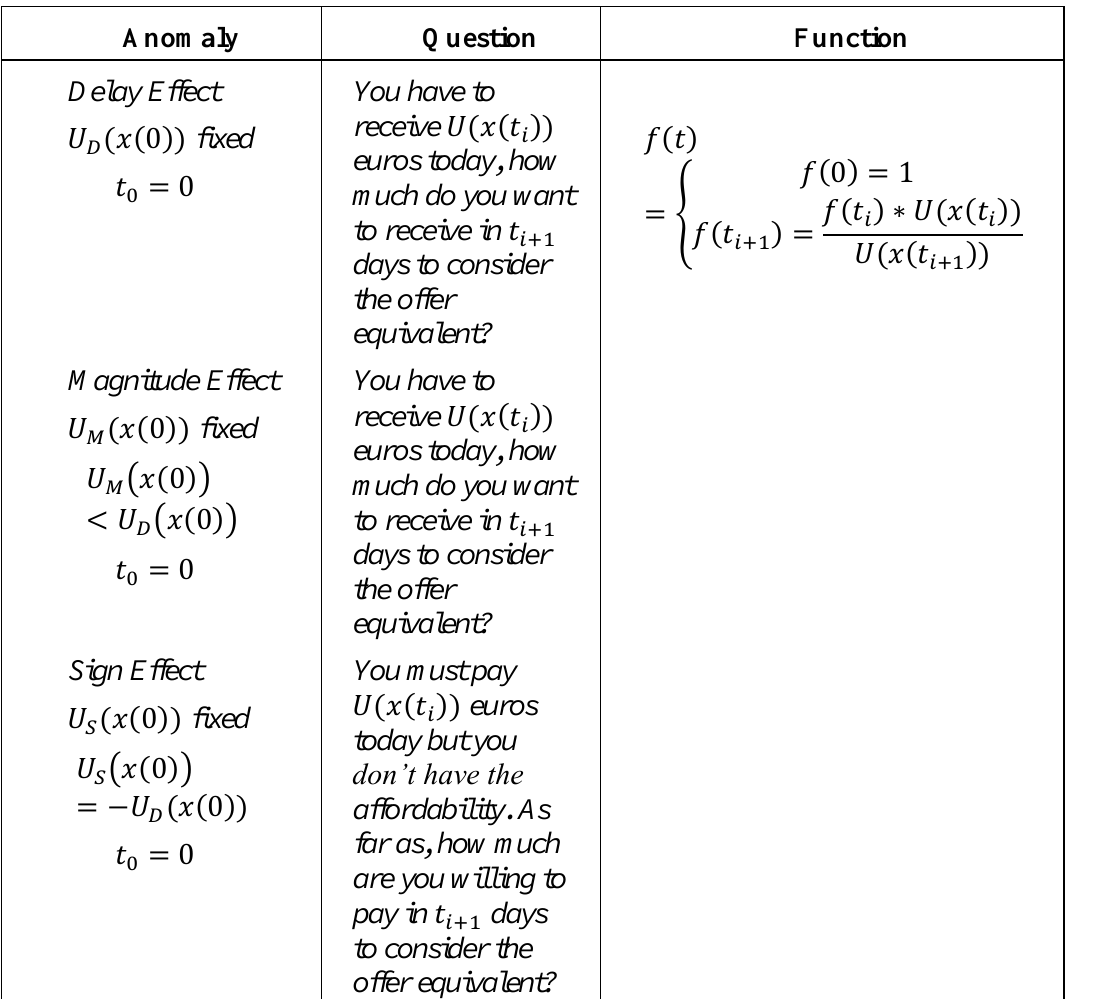
Table 7: Questions to obtain the discount function for each